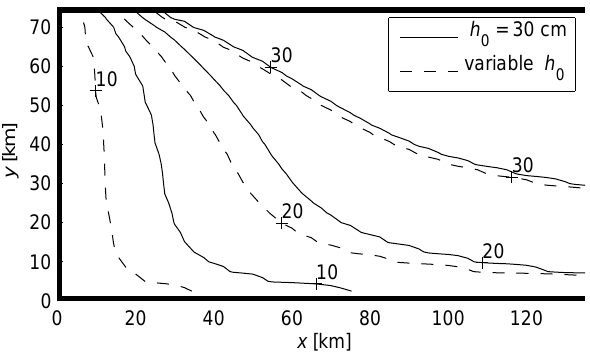
Fig. 12. The polynya edge after eight days using a constant h 0 and parametrised h 0 according to Eq. (15). A =0.8 is used as a marker for the polynya edge and the edge is plotted for 10, 20 and 30m/s wind speed.